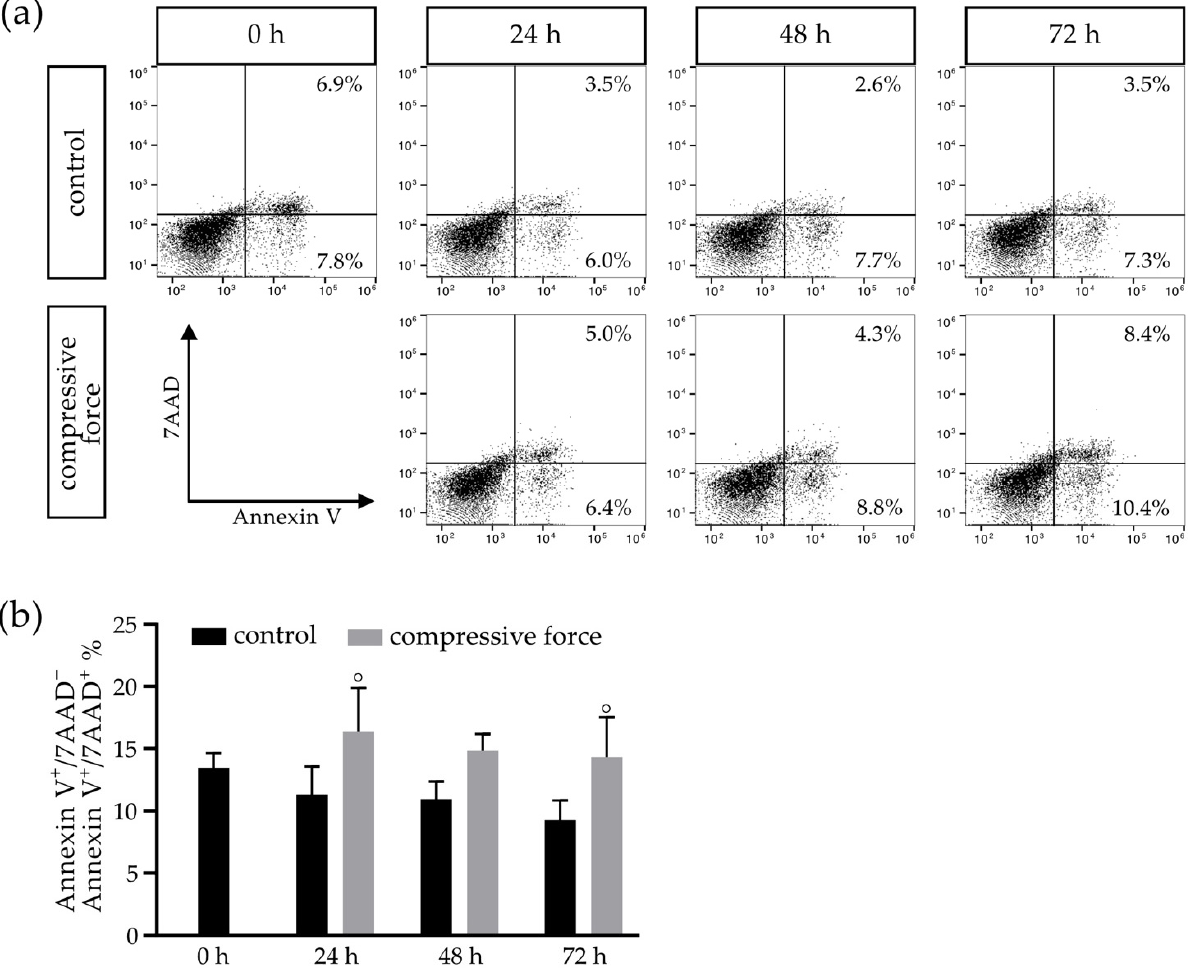
Figure 4. Flow cytometry examination of hPDLFs after Annexin V/7AAD staining in relation to apoptotic cell death, with an exemplary representation of all events at 0–72 h in the control (C) and compressive force (CF) groups ( a ). The total percentage of Annexin V + /7AAD − and Annexin V + /7AAD + events in C showed a dead cell percentage of 15%, which decreased over time, while the proportion in the CF group significantly increased ( b ). Bars indicate the mean values ± standard deviation. A p -value < 0.05 was considered statistically significant. (°) Comparison of the CF with the respective control of the time point.